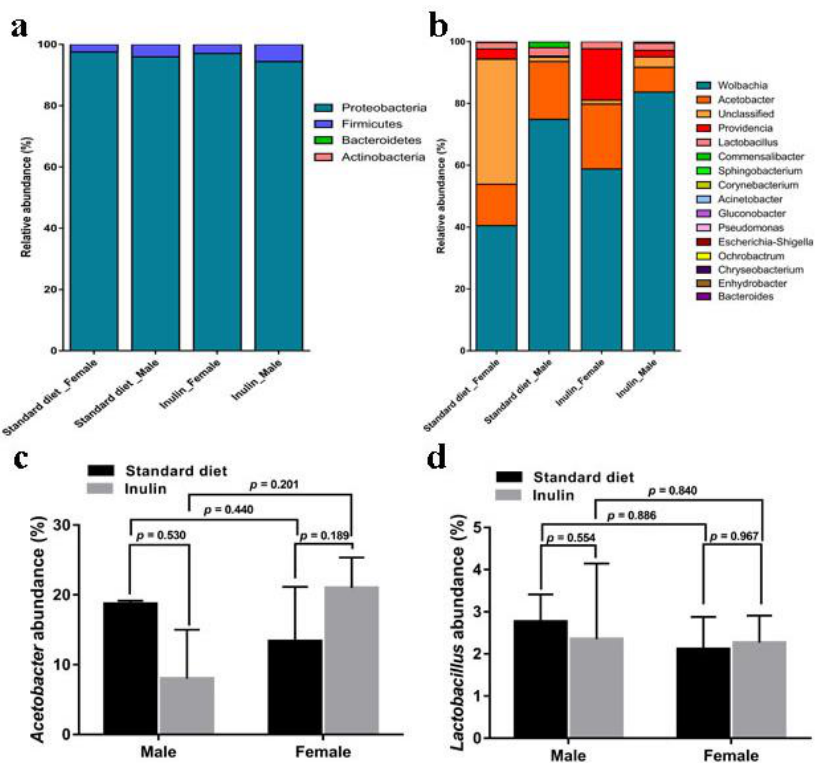
Figure 5. Compositions of gut microbiota for InR p5545 /TM3 D. melanogaster fed an inulin-supplemented diet or a standard diet. Bacterial diversity at the phylum level ( a ) and genus level ( b ). Bacterial abundance of Acetobacter ( c ) and Lactobacillus ( d ).